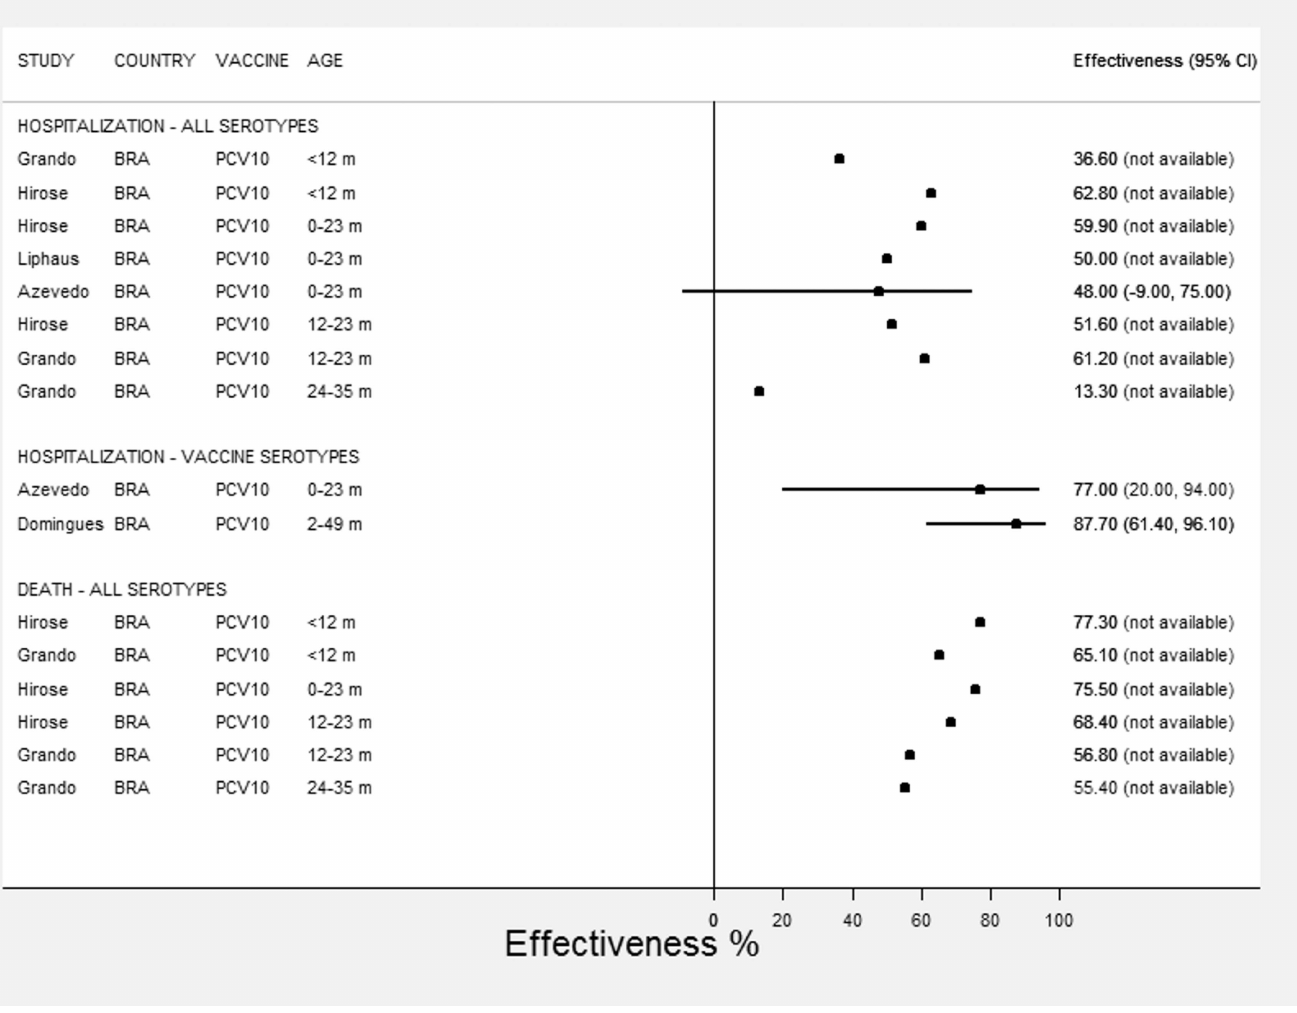
Fig 3. Vaccine effectiveness * against meningitis, by vaccine, group of age, vaccine serotypesand all serotypes, and hospitalization or death. * 95% confidenceintervalswere not reportedby several of the studies and were not plotted. Country: BRA (Brazil).